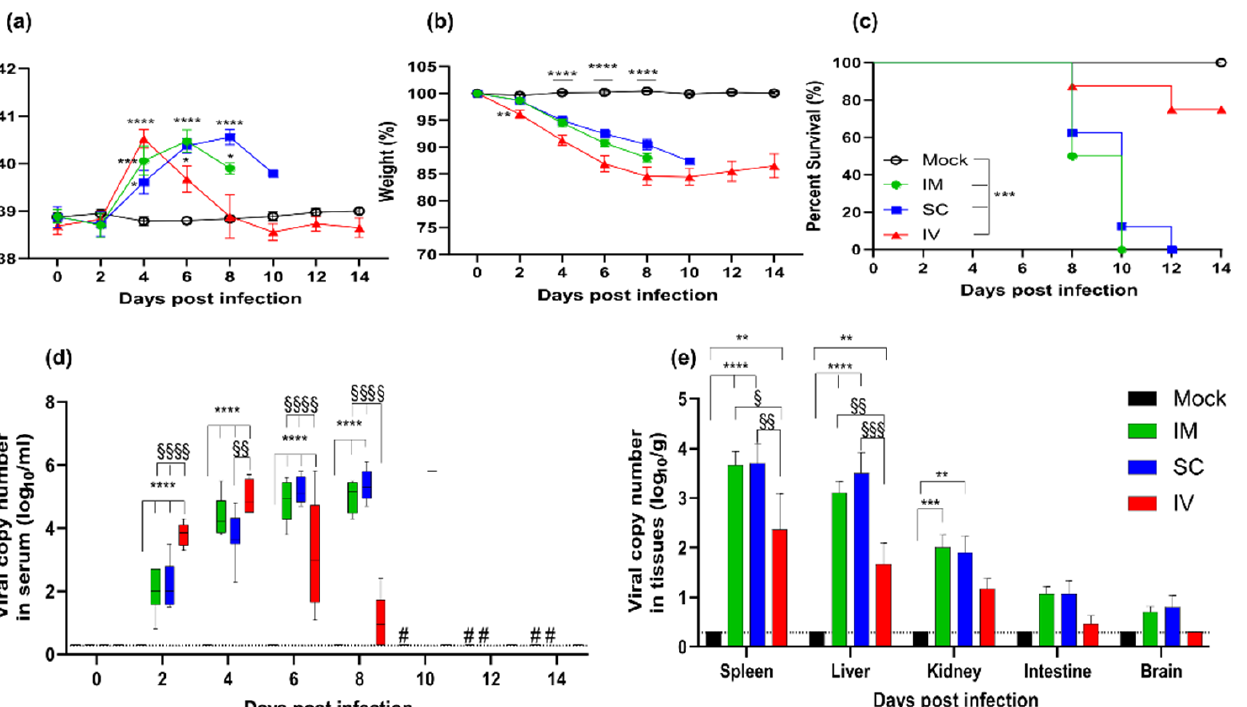
Figure 1. Virulence of severe fever with thrombocytopenia syndrome virus (SFTSV) in aged ferrets via different routes of infection. Eight ferrets per group were inoculated with SFTSV via the intra- muscular (IM), subcutaneous (SC), or intravenous (IV) route. Animals were then assessed every other day for ( a ) temperature changes; ( b ) relative weight; ( c ) Kaplan–Meier survival; ( d ) and viral copy numbers in serum. ( e ) Viral copy numbers in spleen, liver, kidney, intestine, and brain were examined at 6 dpi. The data for the mock, IM, SC, and IV groups are shown in black, green, blue, and red, respectively. Data are presented as mean ± s.e.m ( a , b , e ) or min to max ( d ), and titers below the limit of detection are shown as 0.3 log 10 RNA copy numbers/mL or 0.3 log 10 RNA copy num- bers/g (dashed lines). An asterisk (*) indicates statistical significance when data are compared to those for the mock group (* p < 0.05; ** p < 0.01; *** p < 0.001; and **** p < 0.0001). A section sign (§) indicates statistical significance when data are compared among the virus-infected groups (§ p < 0.05, §§ p < 0.01, §§§ p < 0.001, §§§§ p < 0.0001) with respect to viral copy numbers in serum. Statistical significance was determined by two-way ANOVA with Tukey’s comparison test ( a , b , d , e ) or rank (Mantel–Cox) test ( c ). A sharp symbol (#) indicates that no samples were collected because ferrets in that group died. 3.2. Viral Copy Number Changes in Serum and Tissues